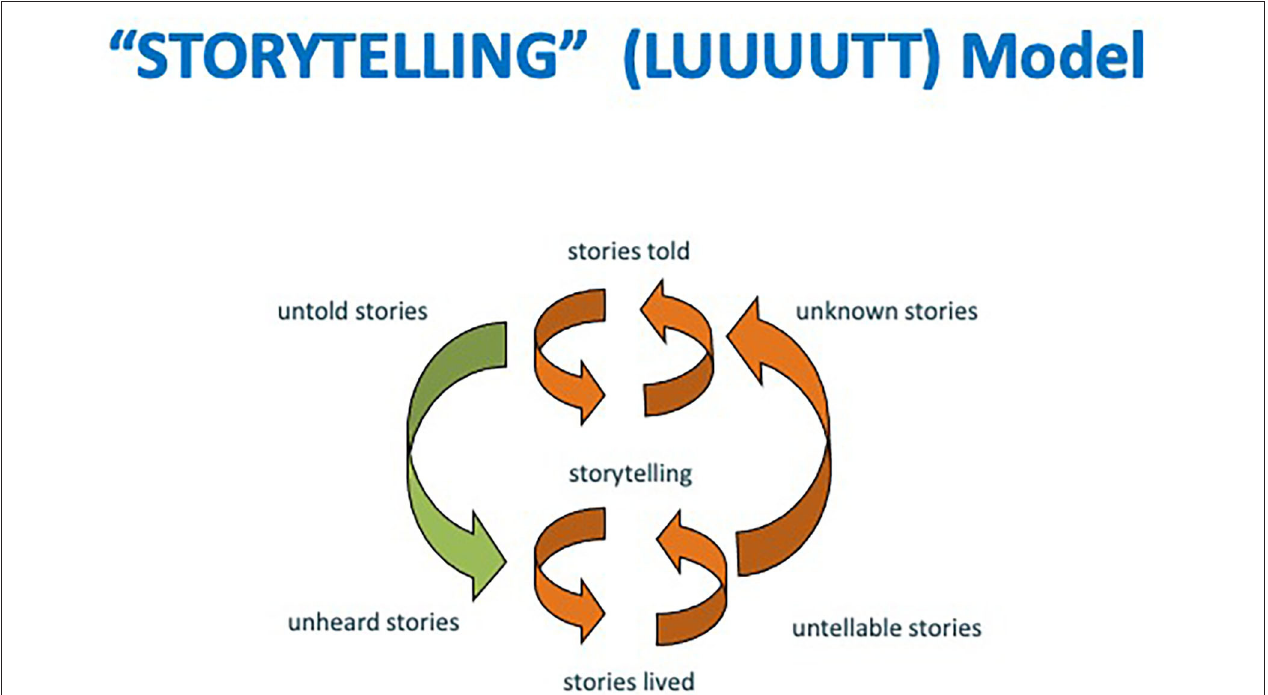
FIGURE 3 | Dynamics of cosmopolitan